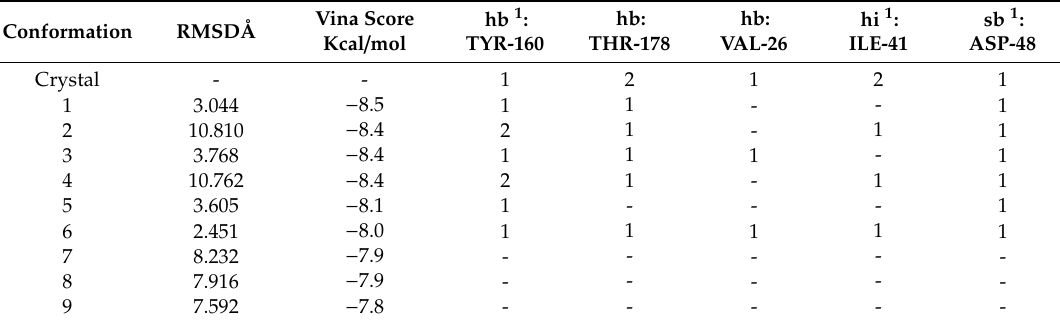
Figure 2. Docking conformations of trimetrexate in complex with Tc DHFR-TS: ( a ) conformation with the lowest free energy of binding; ( b ) conformation with the lowest root-mean-square deviation (RMSD). Docking was performed on the active site using vina. Residues in blue interacted with the docking conformation. In green, residues that interacted in both docking and crystal conformation. White residues are those that only interacted with the crystal conformation. Table 2. Values of RMSD and AutoDock Vina (vina) score of trimetrexate conformations on the active site of Tc DHFR-TS.